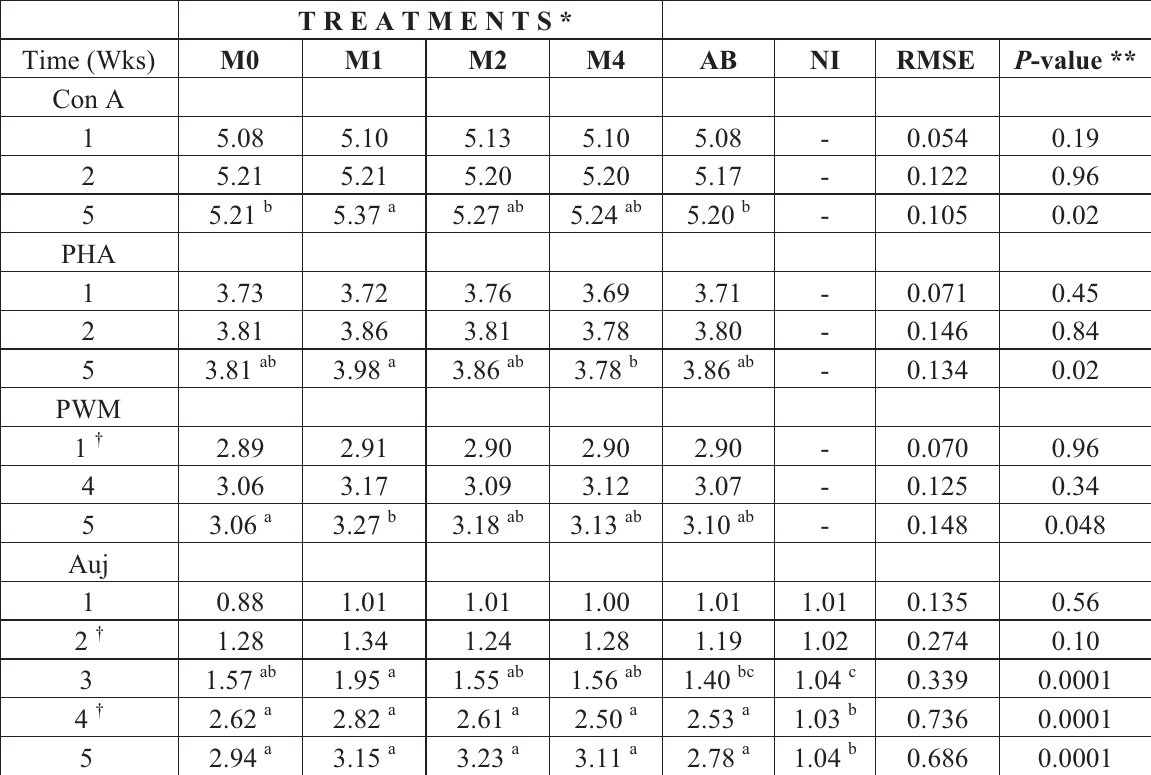
Table 2. Effect of dietary MOS supplementation on non-specific and specific cellular immune response of weaned pigs (lymphocyte stimulation index)